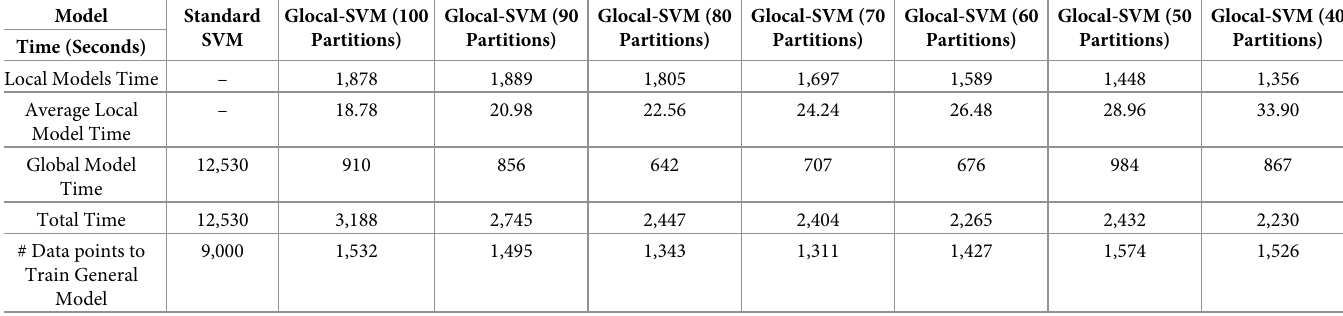
Table 4. Comparing the time performance, in seconds, of the standard SVM model to the Glocal-SVM models (40-100 Partitions).